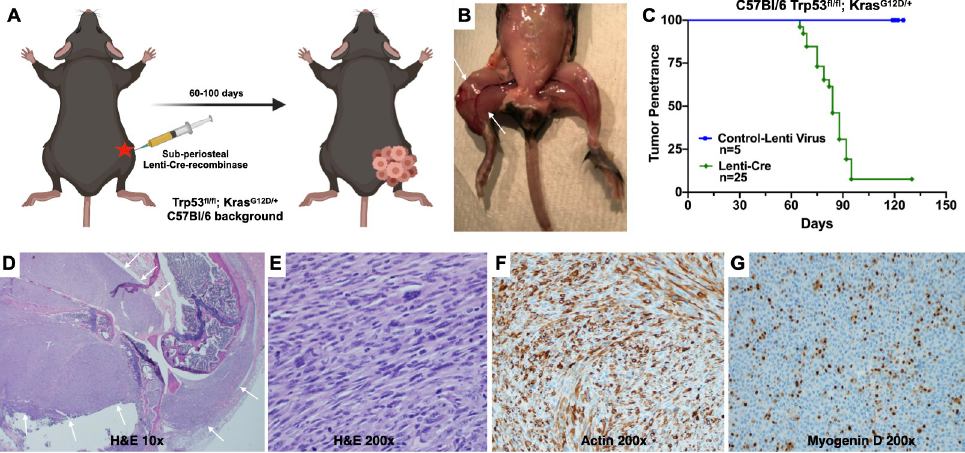
Fig 1. Mutation of Trp53 and Kras in C57Bl/6 mice results in rapid tumour formation. (A-B) Sub-periosteal lenti-cre injection into the tibialis anterior muscle of C57Bl/6 mice results localized tumour growth involving the entire hindlimb. (C) Tumours develop in greater than 90% of injected mice with a short latency of 2–3 months from lenti-virus injection until tumours are palpable. (D-E)10x and 200x magnification photomicrographs of UPS tumours showing a malignant, highly pleomorphic spindle cell sarcoma. (F-G) Immunohistochemical studies show strong actin staining and patchy Myogenin expression, consistent with a diagnosis of UPS. White arrows delineate the tumour margin on both gross necropsy and low magnification